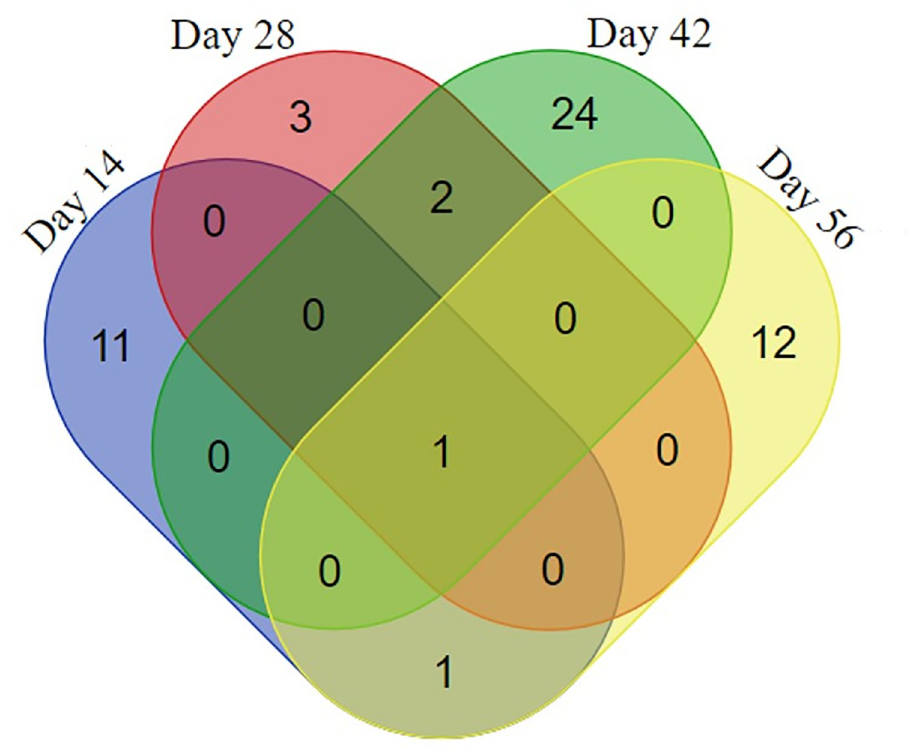
Fig 5. Circulating proteins of S . mekongi identified in infected mouse sera at 14-, 28-, 42-, and 56-days post- infection using mass-spectrometric analysis. Numbers represent the number of S . mekongi circulating proteins identified by mass